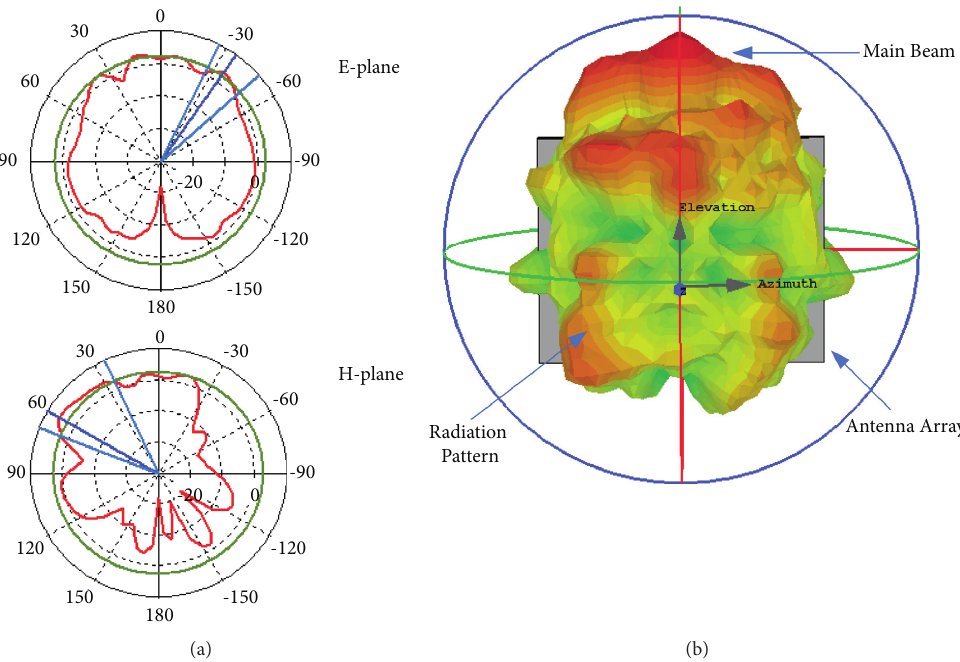
Figure 9: The antenna radiation patterns at the operating center frequency of 15.5GHz: (a) polar radiation pattern; (b) 3D radiation